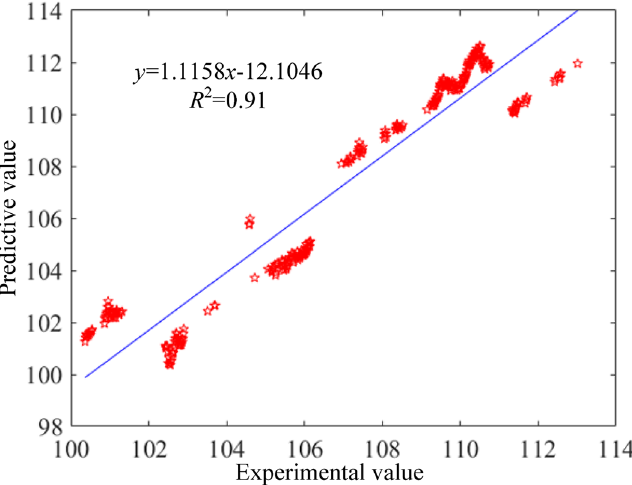
Figure 9. Residual comparison of noise between predictive and experimental values.